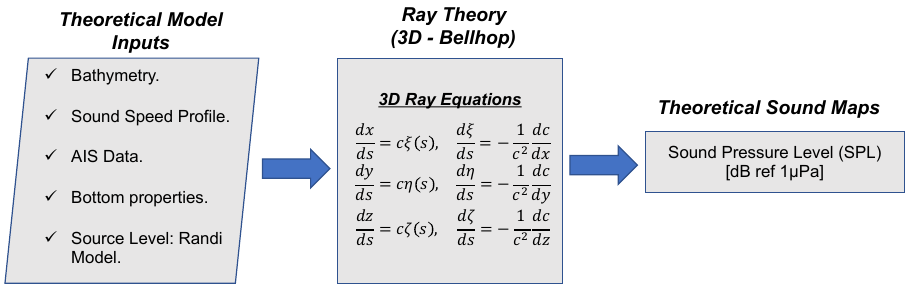
Figure 5. Flowchart for the computation of the sound